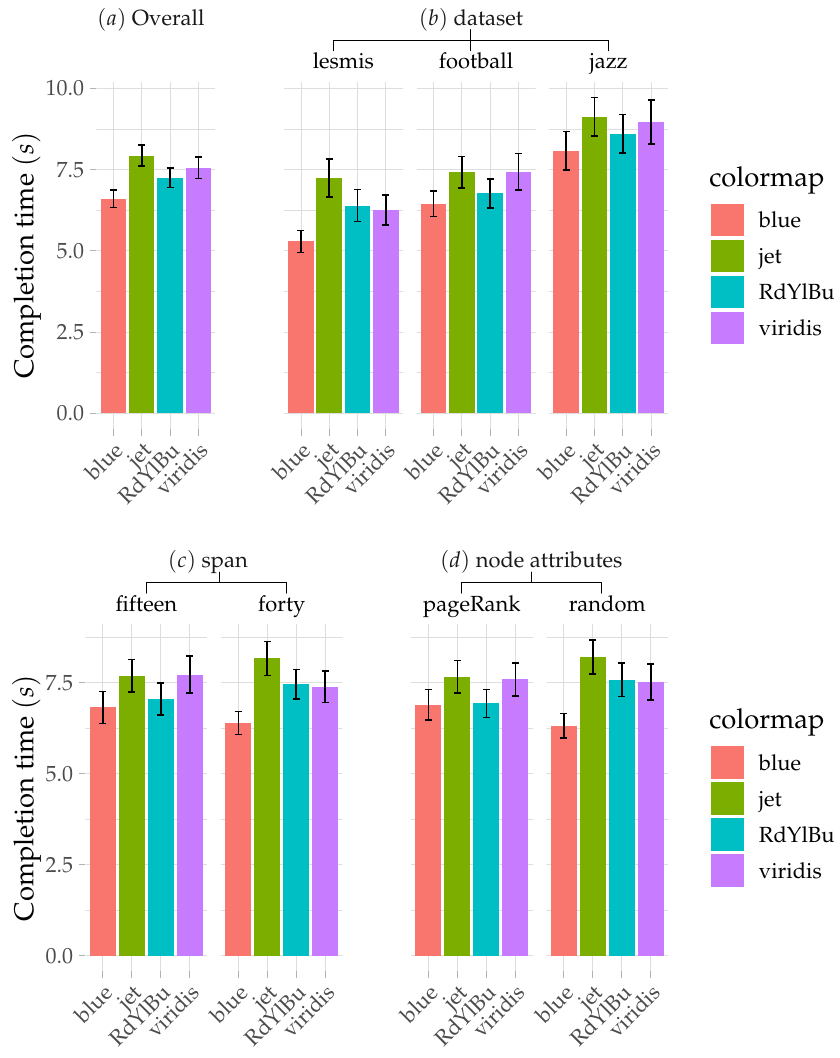
Figure 3. Results of the experiment for task completion time . ( a ) Shows the overall task completion time for each colormap which is then broken down further into datasets ( b ), and span ( c ), and node attributes ( d